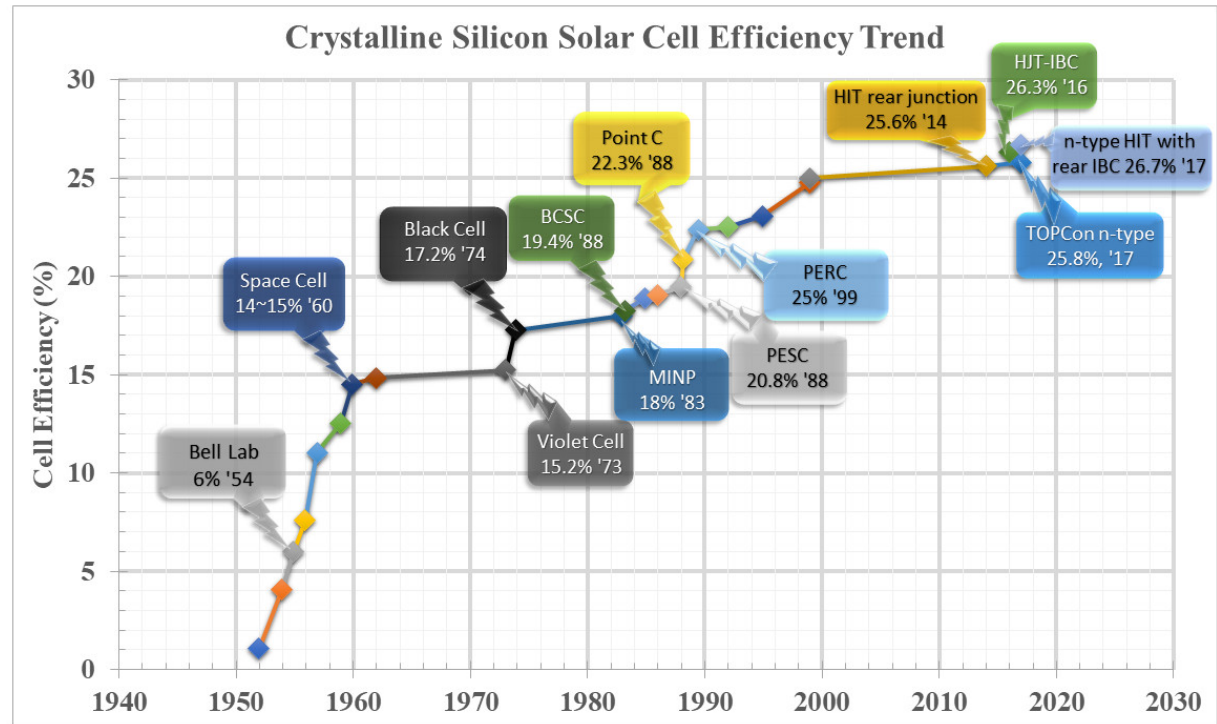
Figure 1. Crystalline silicon solar cell efficiency trend to date.